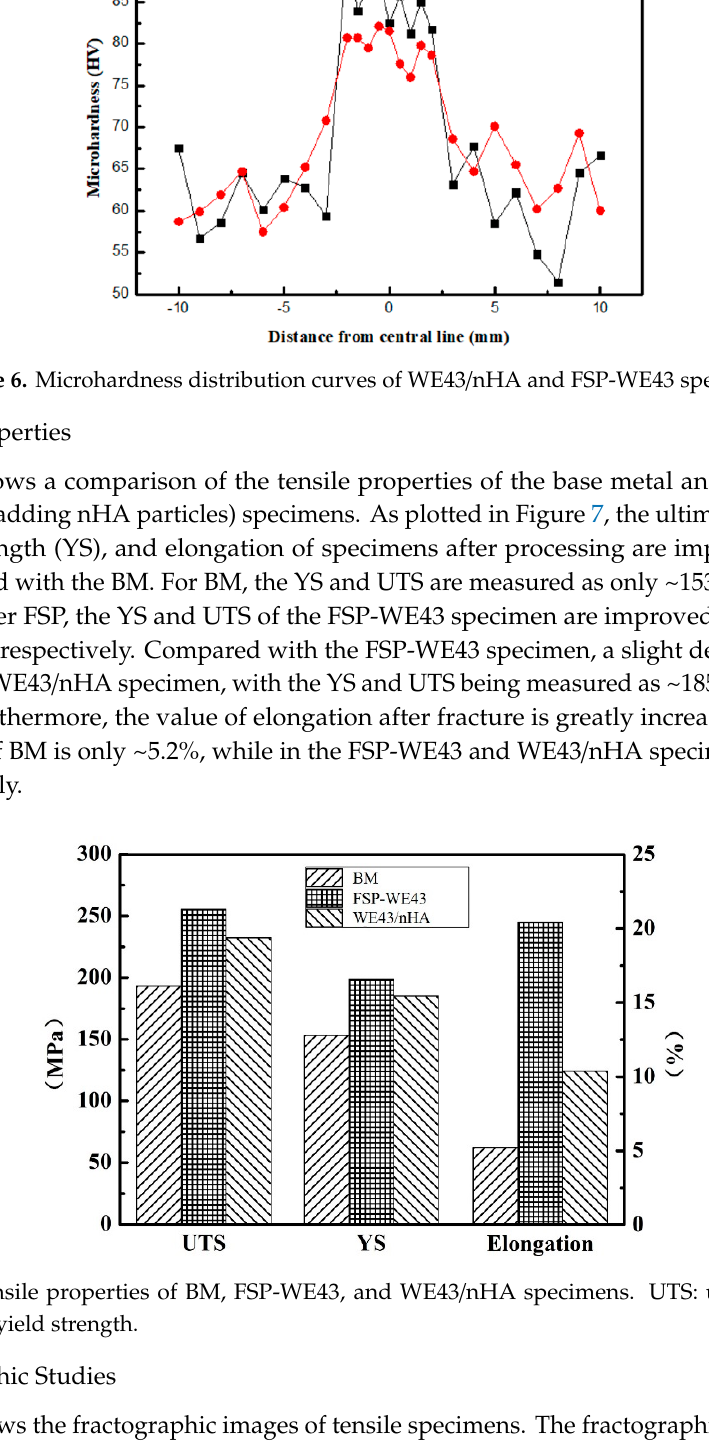
6 of 13 Figure 5. ( a ) SEM image; ( b ) TEM image; and ( c ) EDS analysis of the WE43/nHA specimen. The grain size of as-cast WE43 alloy is coarse and the microstructure is ununiform, so the microhardness value of the BM zone is lower and fluctuates. After FSP, the grains in the stir zone are